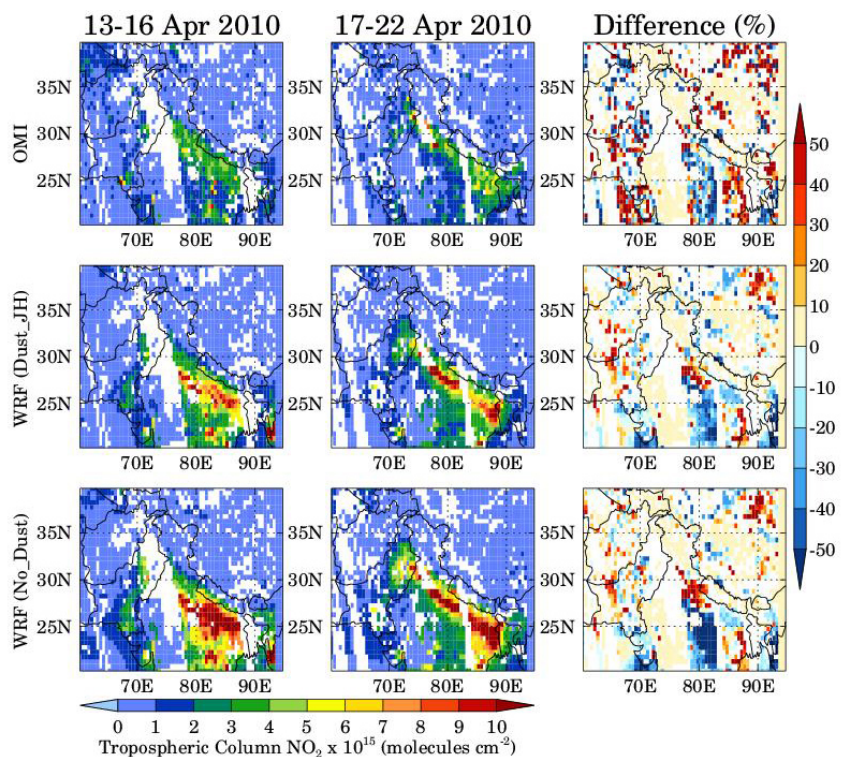
Figure 3. Spatial distributions of OMI-retrieved and WRF-Chem-simulated (Dust_JH and No_Dust) tropospheric column NO 2 during the low (13–16 April 2010) and high (17–22 April 2010) dust emission periods. WRF-Chem profiles are convolved with OMI averaging kernels before comparison. The percentage differences between low and high dust emission periods are also shown.